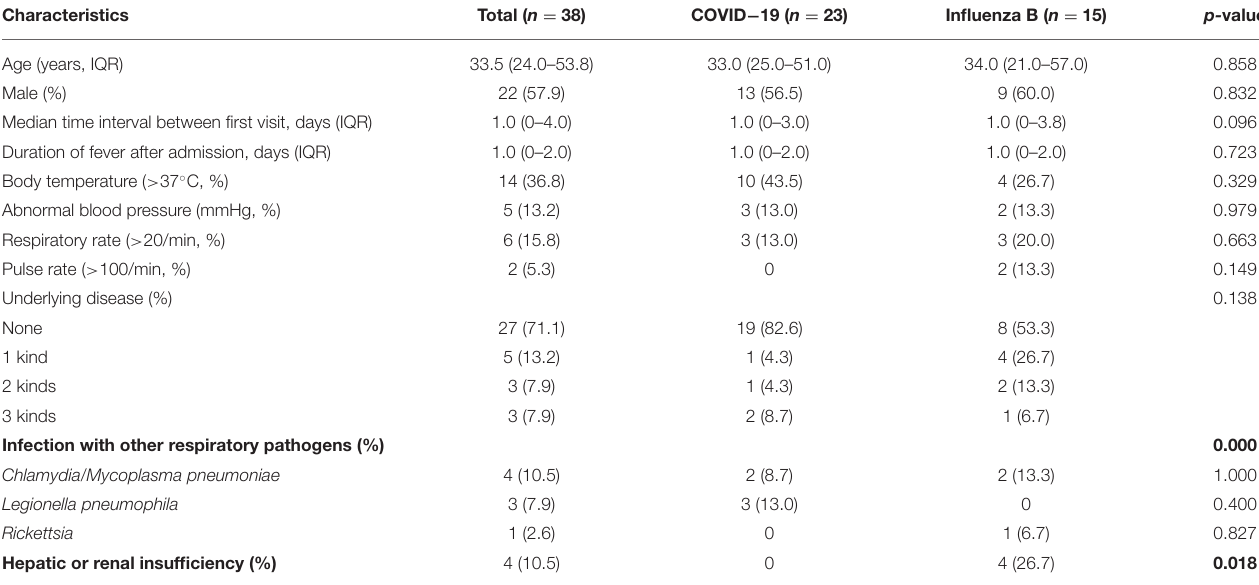
TABLE 2 | Characteristics of patients with COVID-19 or influenza B. Characteristics